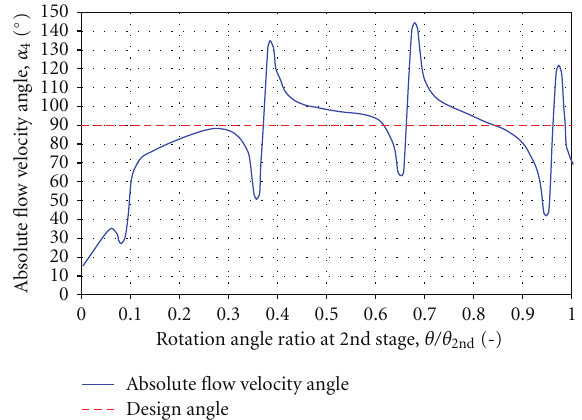
Figure 19: Absolute flow velocity angles of 2nd runner stage outlet along the normalized rotation sector at design conditions.